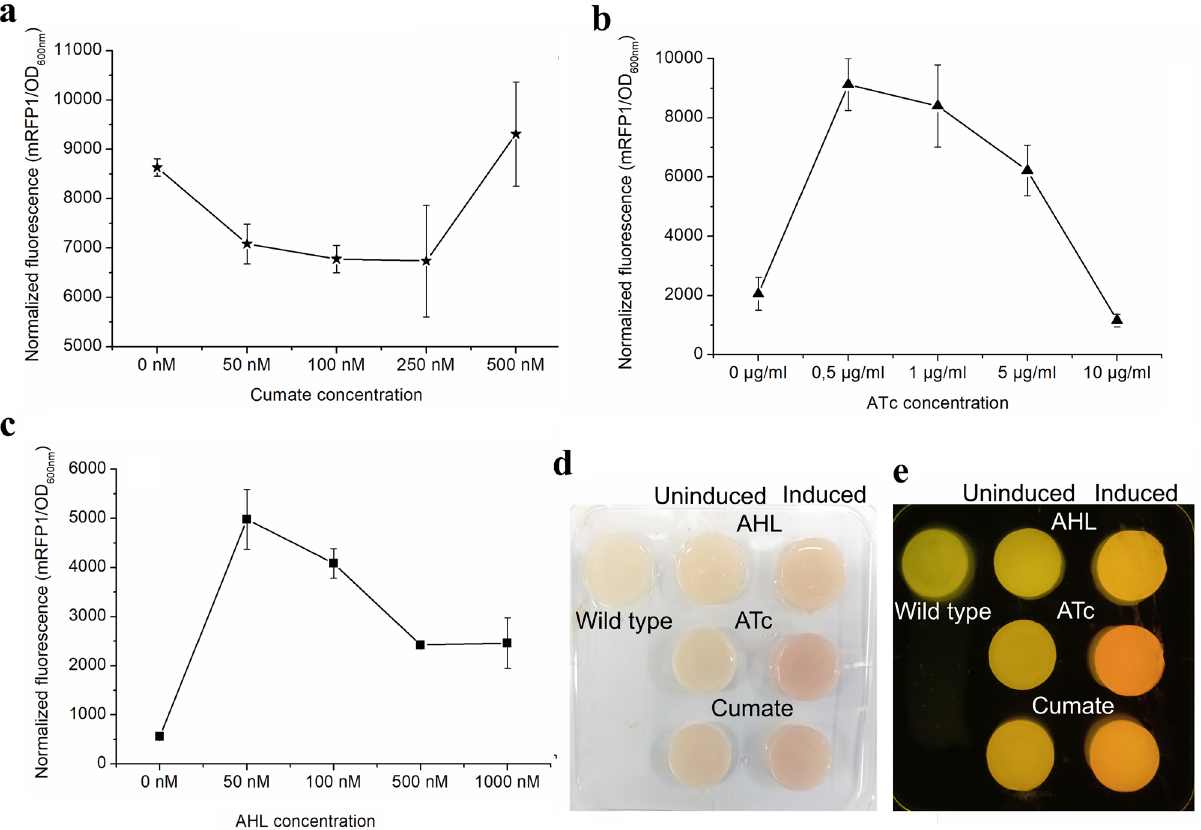
Figure 5. Characterization of inducible constructs in K. intermedius ENS15. ( a–c ) mRFP1 expression using AHL-, ATc- and Cumate-inducible constructs as measured by normalized fluorescence (mRFP1